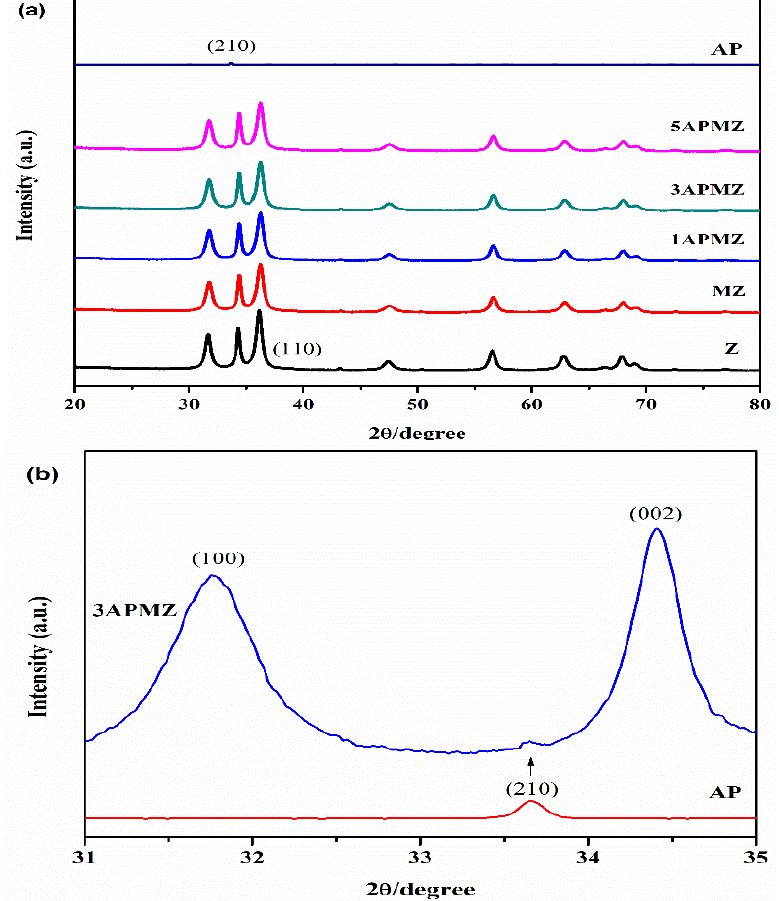
Figure 2. ( a ) XRD patterns of Z, MZ, 1APMZ, 3APMZ, 5APMZ, and AP samples. ( b ) Enlarged view of XRD for AP and 3APMZ samples.